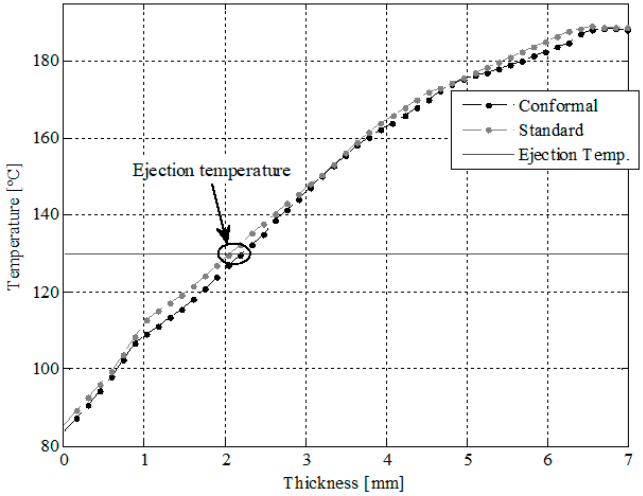
Figure 22. Temperature profile [°C] versus thickness [mm] in the collimator region for the beginning of the ejection phase of the plastic part.